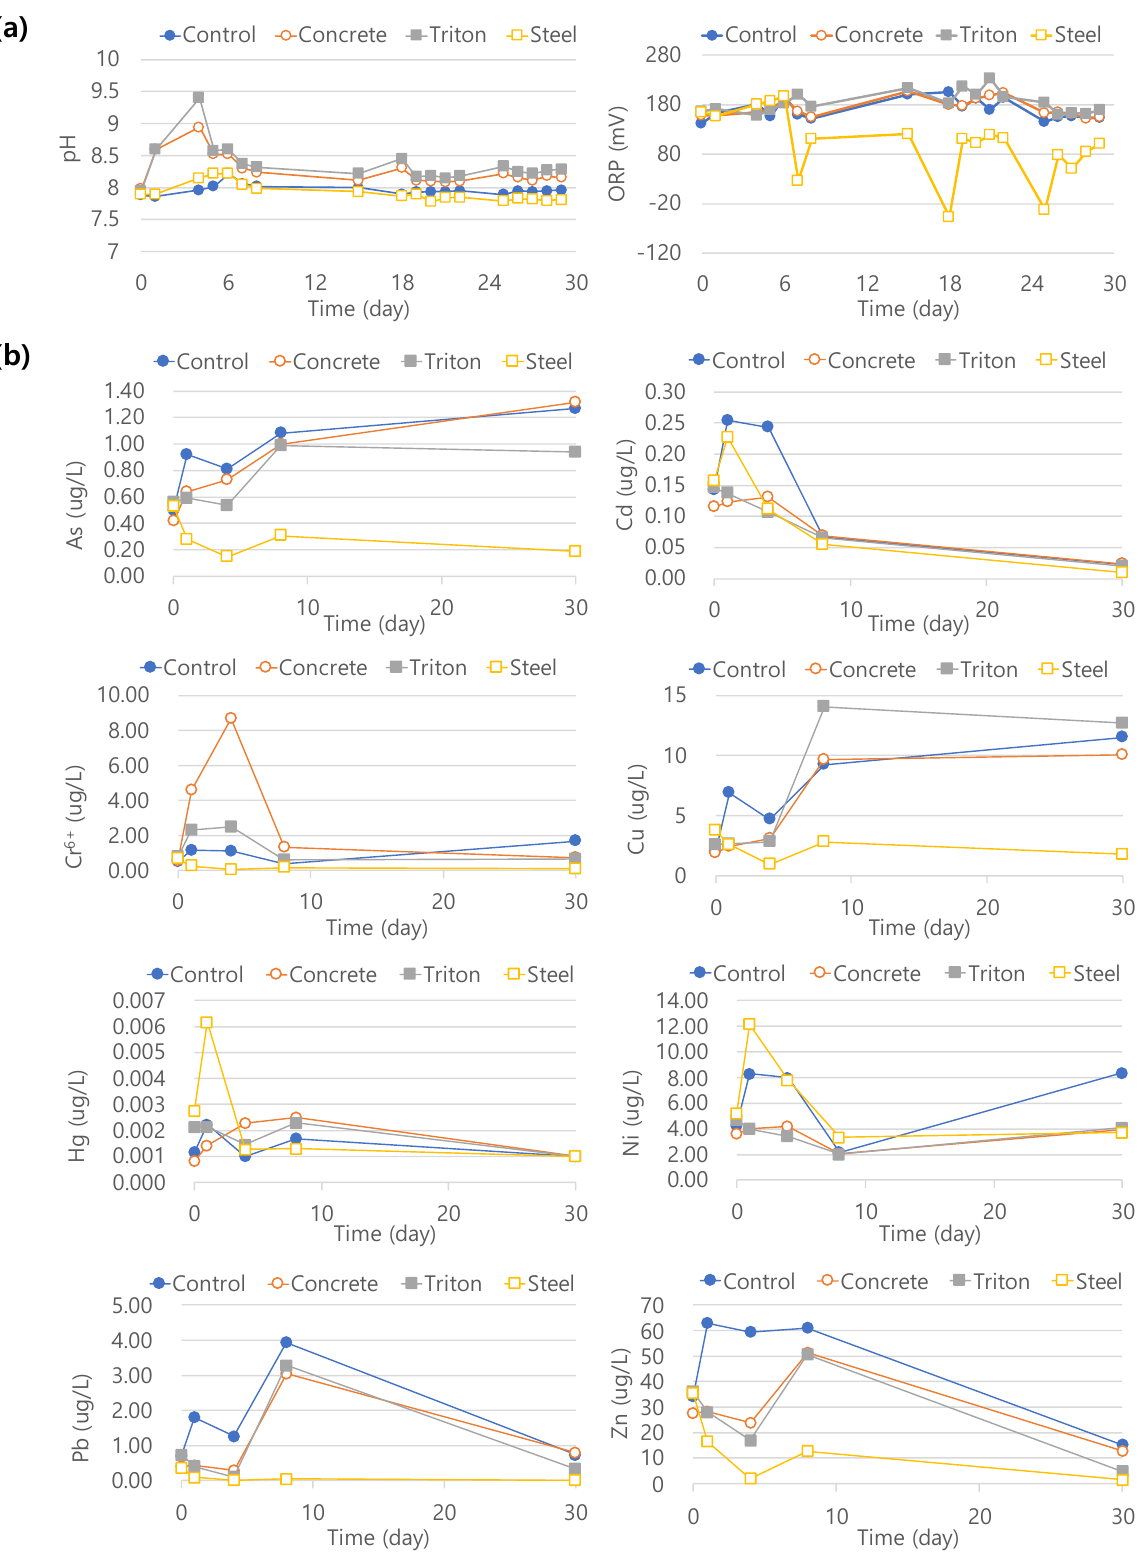
Figure 6. Results of the indoor elution experiment with natural seawater exchange. ( a ) Changes in the pH and ORP and ( b ) the concentrations of heavy metals for the control (without artificial reef model) and artificial reef cases.